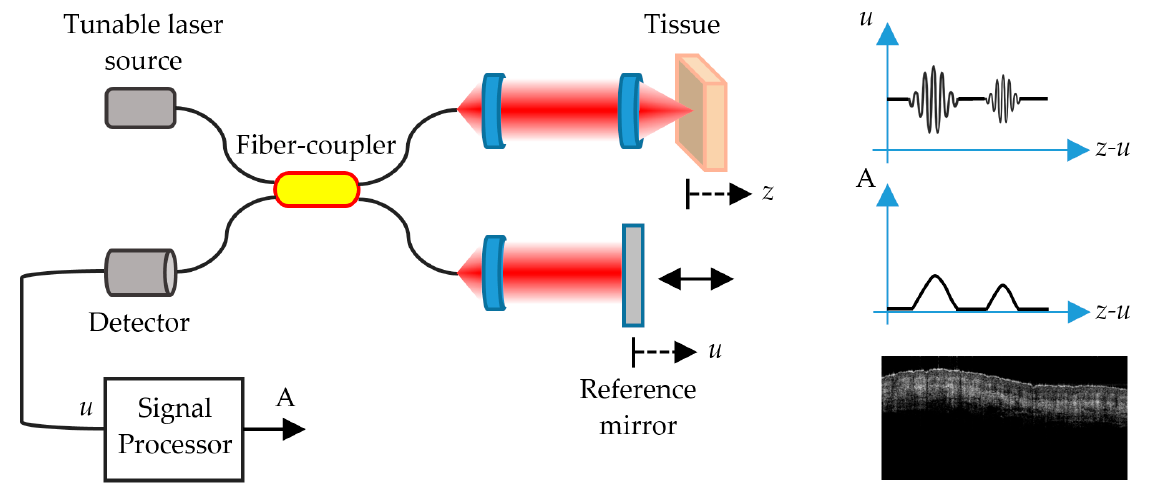
Figure 4. Schematic representation of an SS-OCT imaging system. u is the reference signal and A is the interference signal that produces the image of the different layers of the skin.